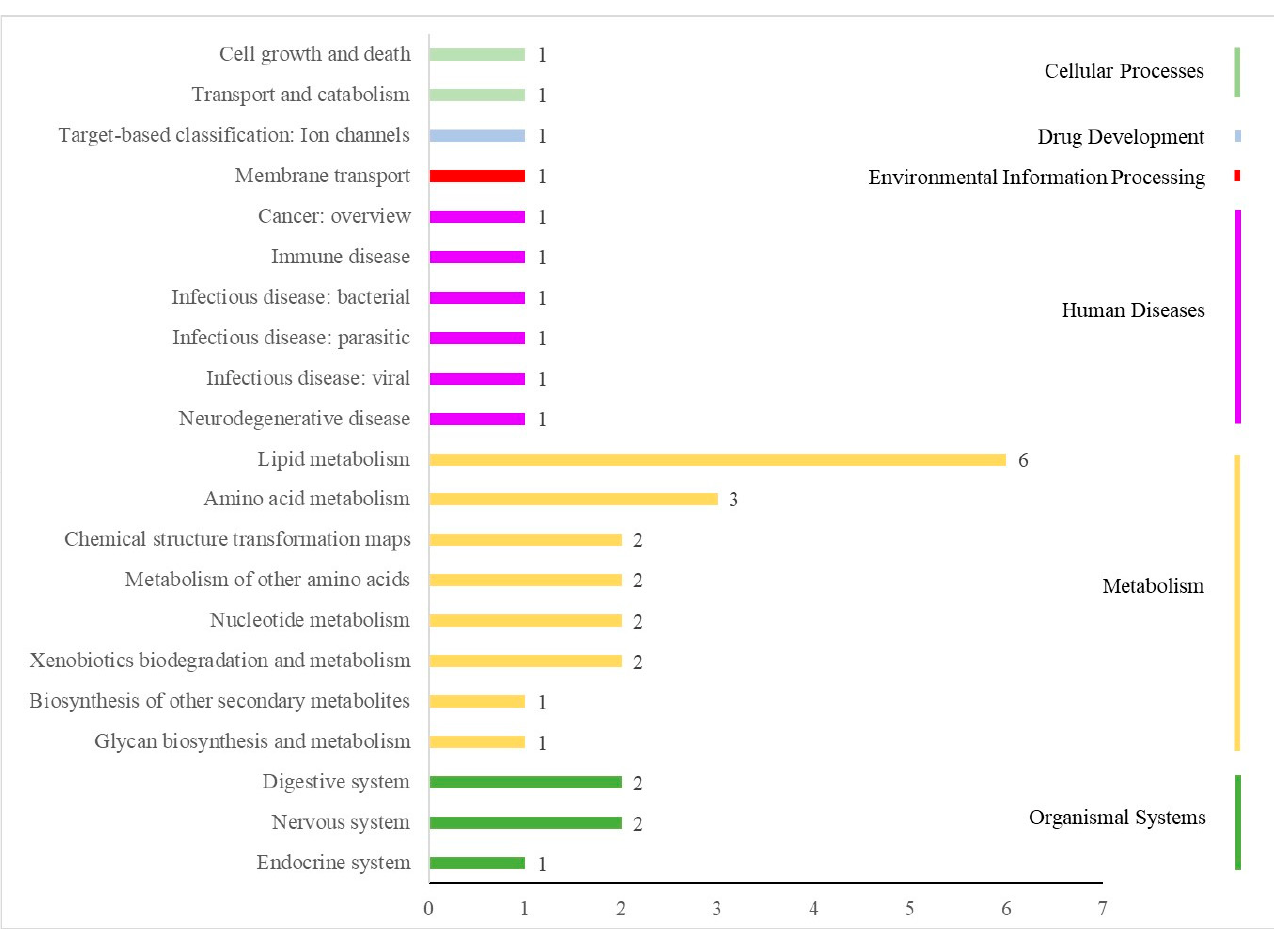
Figure 4. The KEGG analysis of differential metabolites. The abscissa is the number of differential metabolites involved.